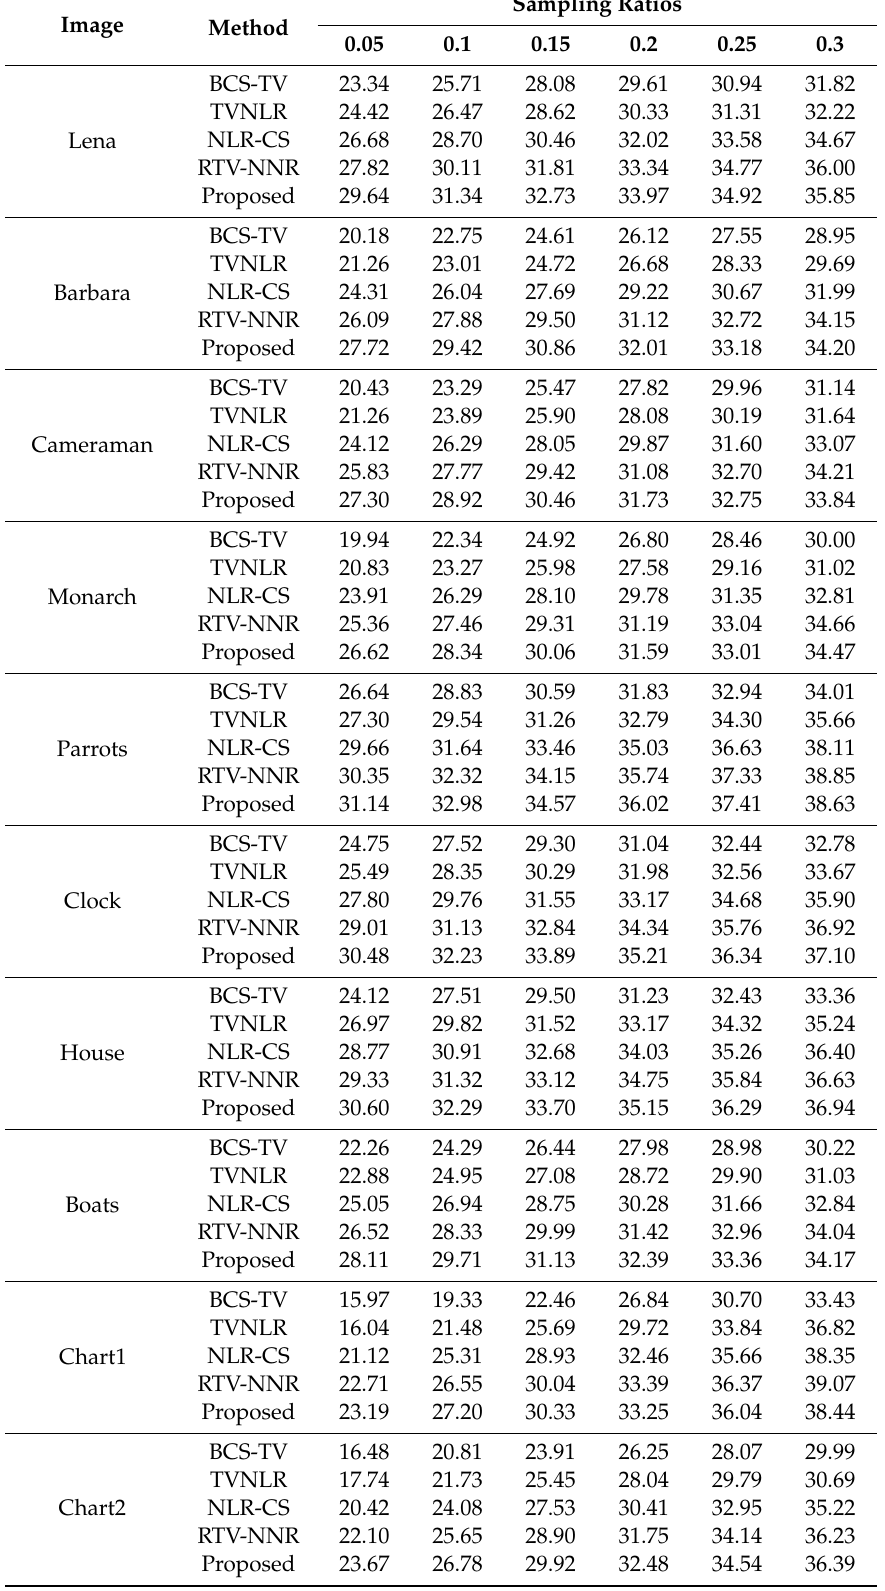
Table 1. Peak signal-to-noise ratios (PSNR) comparisons of five algorithms (unit: dB).